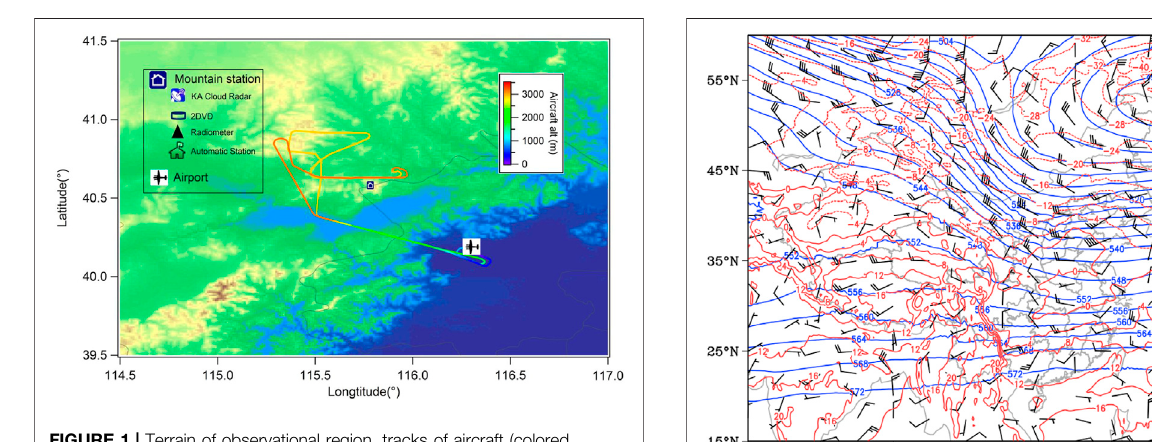
FIGURE 1 | Terrain of observational region, tracks of aircraft (colored